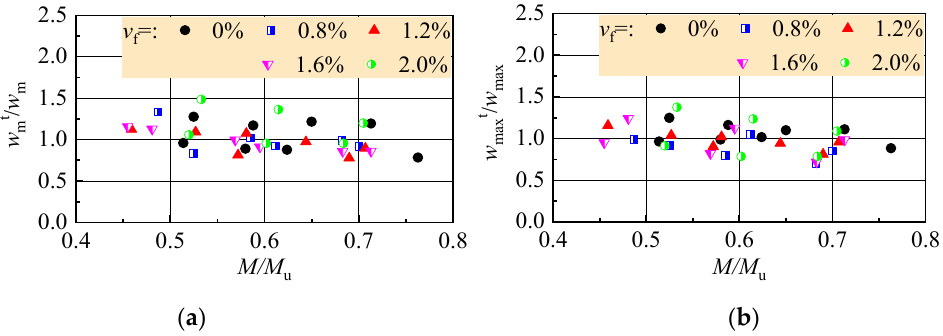
Figure 13. Ratio of tested to calculated values: ( a ) average crack width; ( b ) maximum crack width.